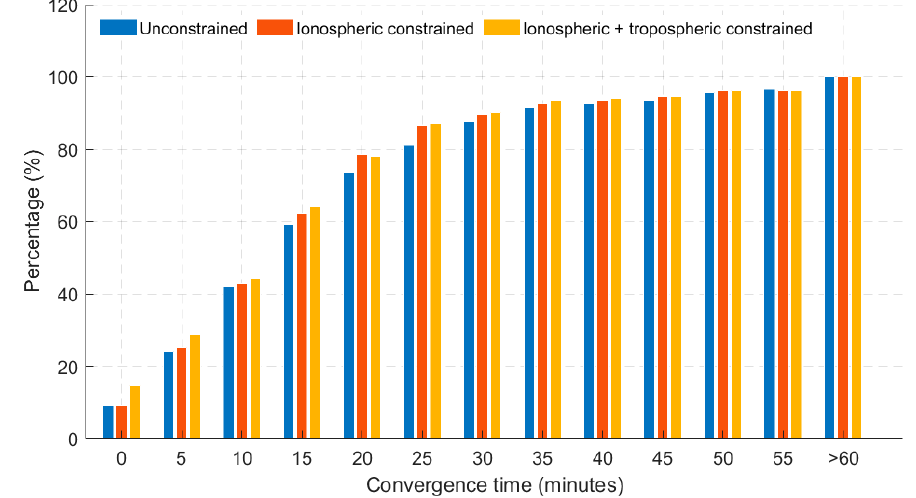
Figure 6. Histogram showing percentage of 40 stations converging based on 24 hourly solutions in dual-frequency GREC processing mode. Results shown have a 20 cm horizontal error threshold.